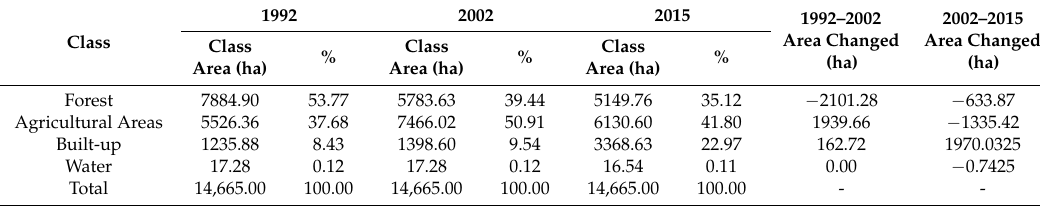
Table 4. Land Cover and Percentage of Land Cover Change in Mount Makiling Forest Reserve Watersheds in three periods: 1992, 2002, and 2015.